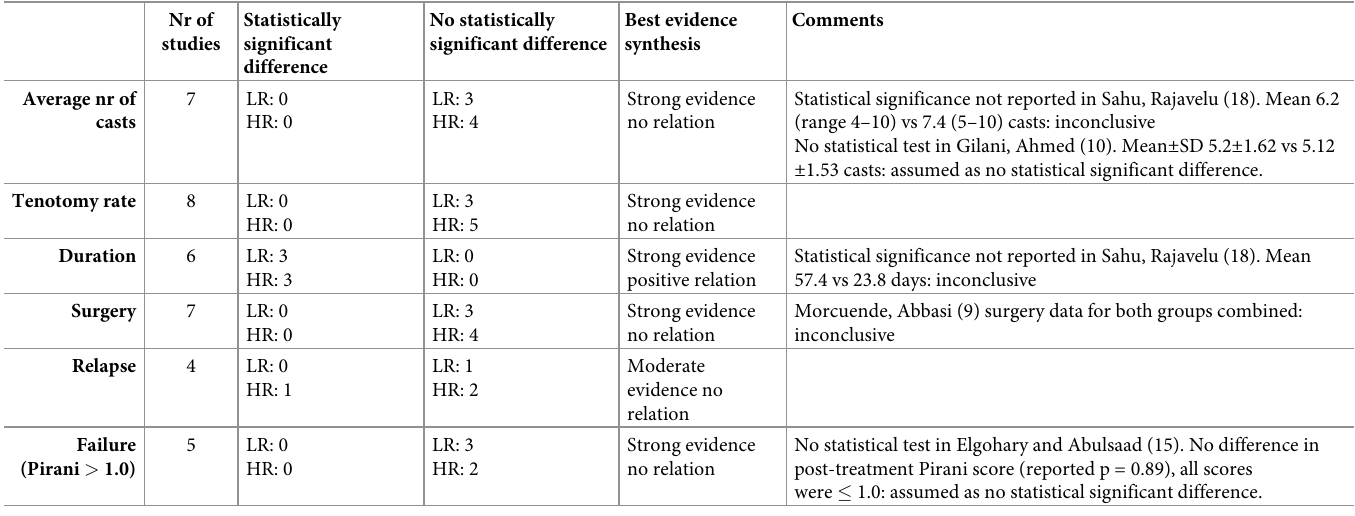
Strong evidence No statistical test in Elgohary and Abulsaad (15). No difference in no relation post-treatment Pirani score (reported p = 0.89), all scores were (cid:20) 1.0: assumed as no statistical significant